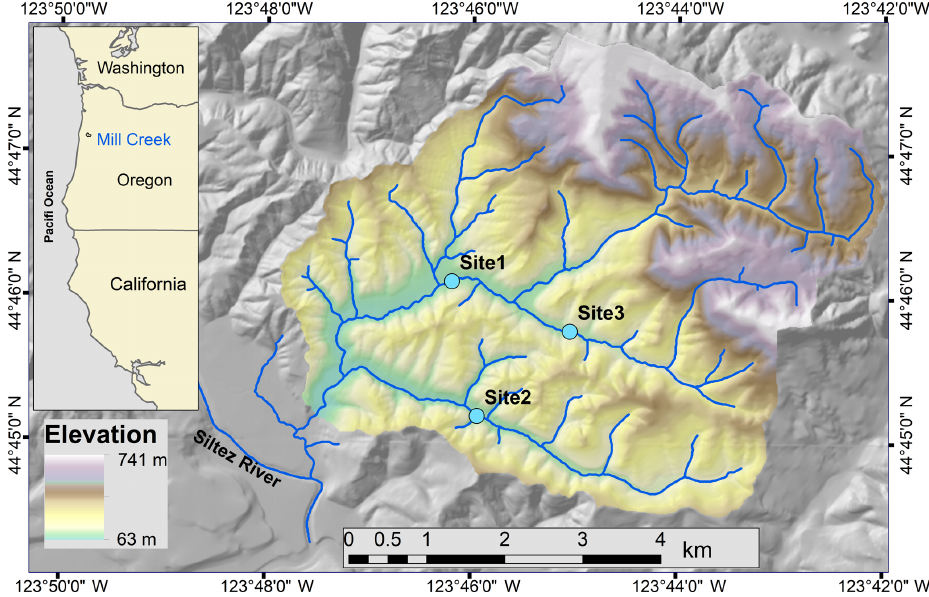
Figure 1. Location of the Mill Creek watershed, OR, and the study sites: 1, 2, and 3.